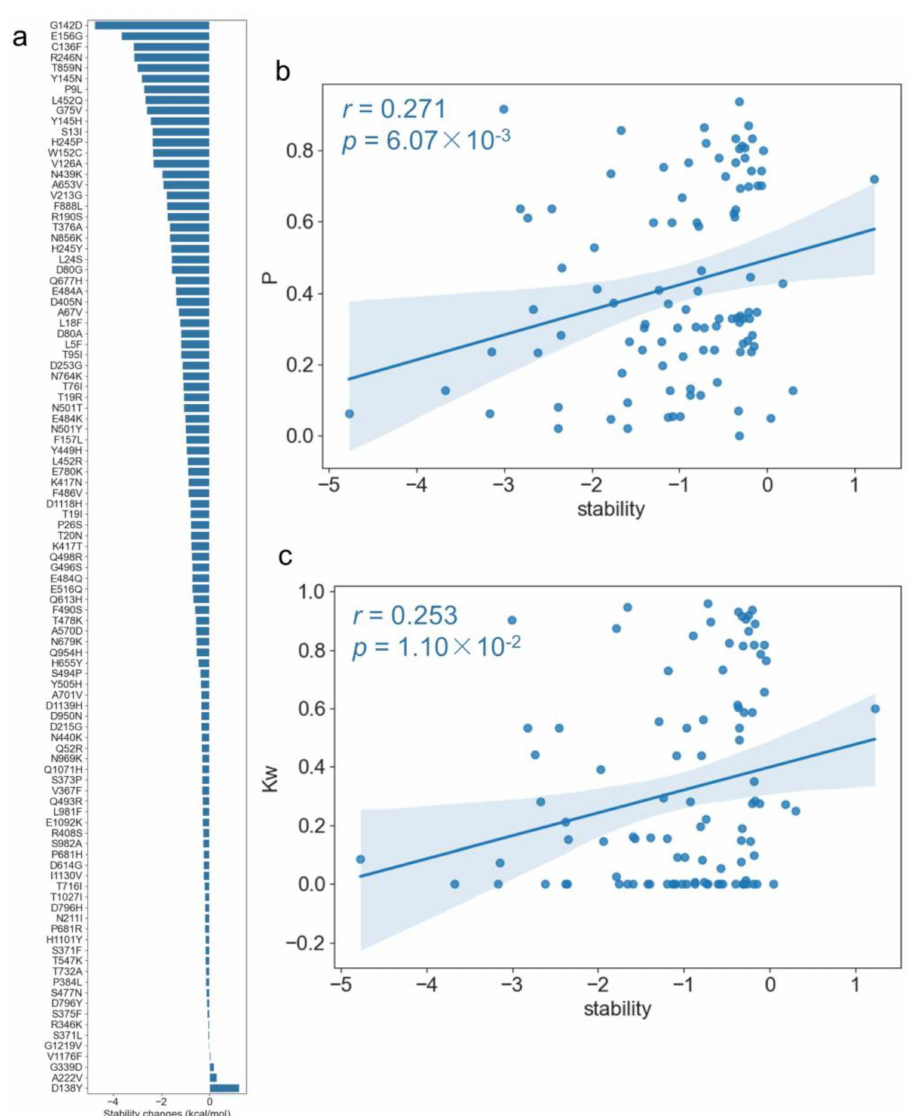
Figure 8. The correlation between the stability changes of the spike protein upon the mutations and PCCN topological features. ( a ). Stability changes in the spike protein upon the point mutations. ( b ). Page rank was positively significantly correlated with stability changes. ( c ). The average neighborhood weighted degree was positively significantly correlated with the stability